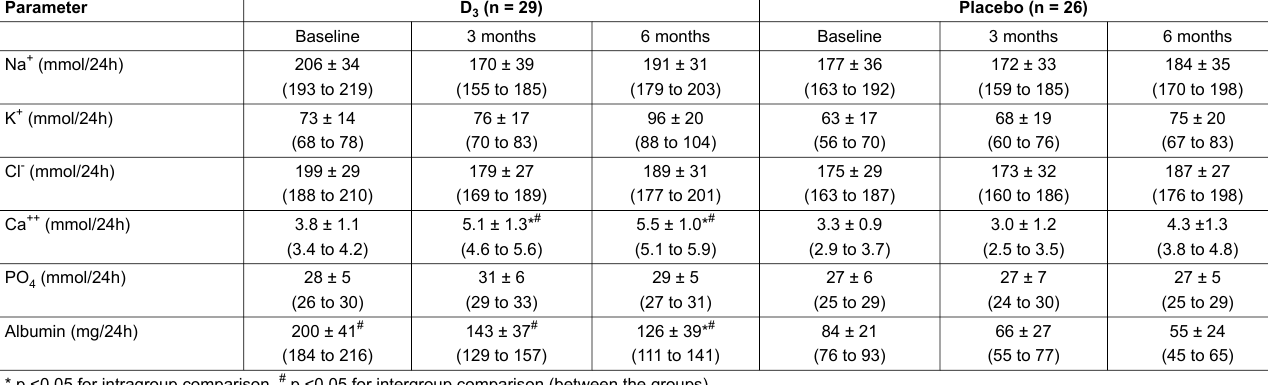
Table 5: Effect of vitamin D (D 3 ) supplementation on 24-hour urinary electrolytes and albumin excretion rates (mean ± standard deviation, 95% confidence interval). Parameter